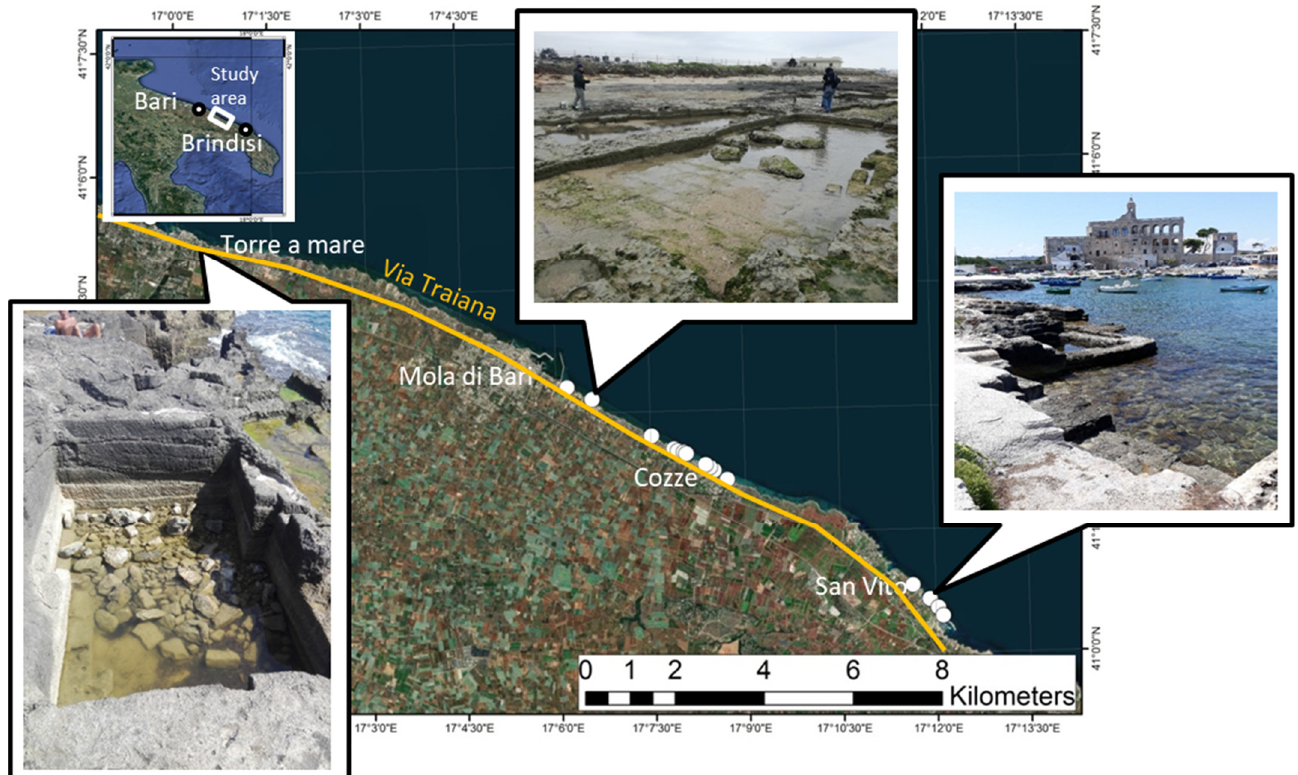
Figure 1. The coastal area of the province of Bari with the location of Roman quarries (white dots) is located near the Via Traiana (in orange).